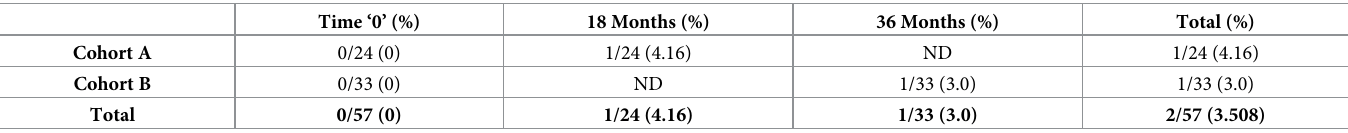
Table 1. Mf status of cryptic individuals followed up for 18 and 36 months in village Kanapur and